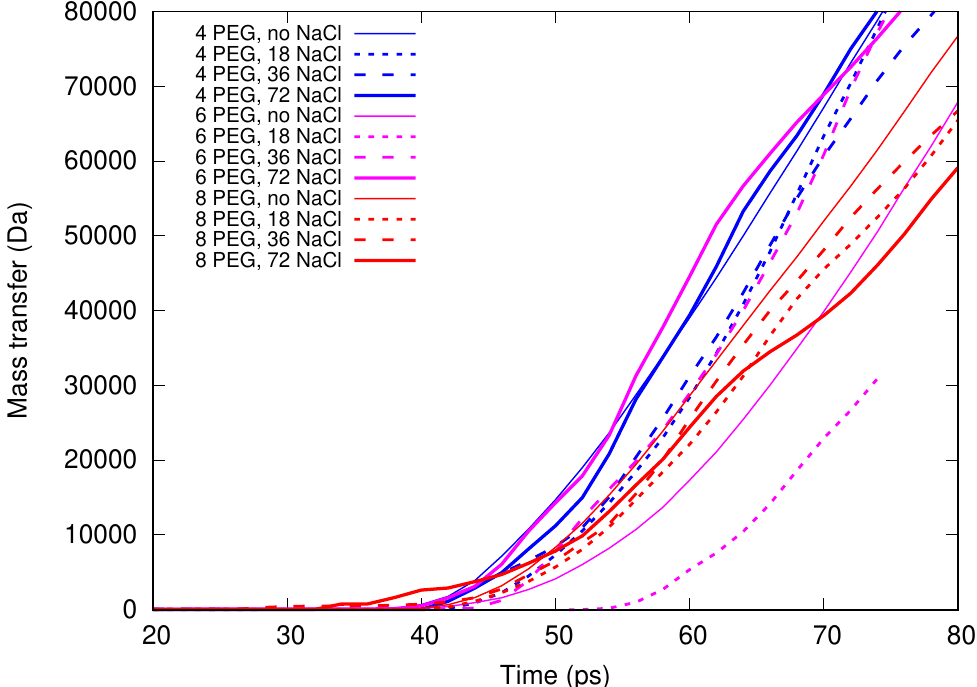
Figure 11. Mass transported through the plane at z = 20 nm as a function of production time for samples with 10.55-kDa PEG chains under 1.5 V/nm. Curves correspond to different numbers of chains and NaCl ion pairs, see the legend. Plotted with gnuplot